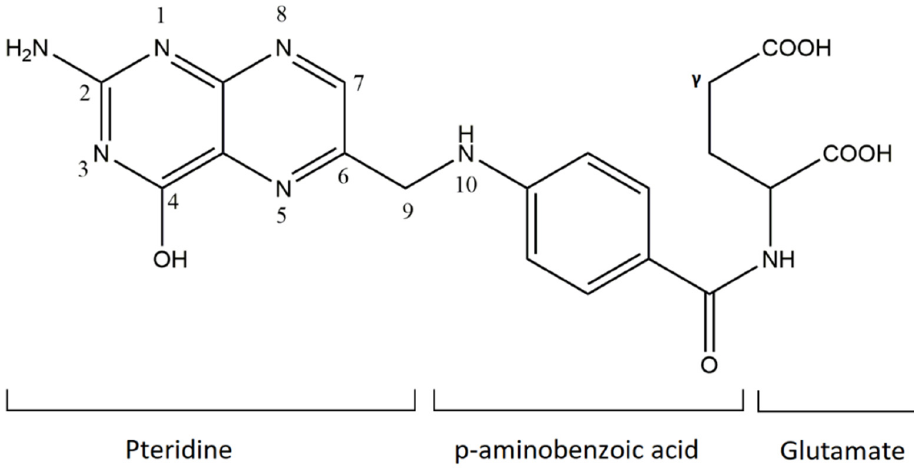
Figure 1. Schematic representation of folic acid (mono-glutamate derivate).